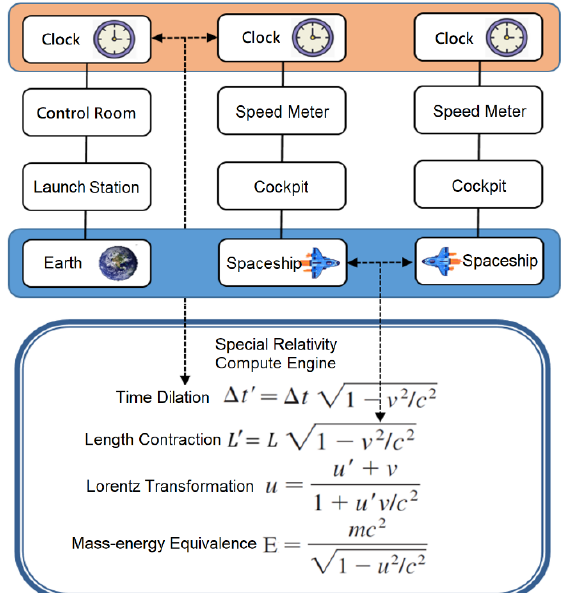
Figure 1. System architecture of the virtual reality (VR) system.